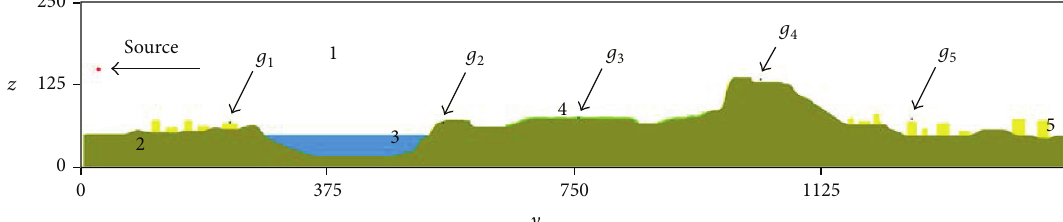
Figure 1: Geometry of the problem: 1: atmosphere ( 𝜀 = 1.0 , 𝜎 = 0 ), 2: dry soil ( 𝜀 = 4.5 , 𝜎 = 10 −3 ), 3: fresh water ( 𝜀 = 90 , 𝜎 = 2.0 ⋅ 10 −2 ), 4: forest ( 𝜀 = 1.2 , 𝜎 = 1.0 ⋅ 10 −4 ), and 5: brick buildings ( 𝜀 = 3.0 , 𝜎 = 10 −4 ). 𝑔 𝑗 , 𝑗 = 1, 2, .. ., 5 -observation points.